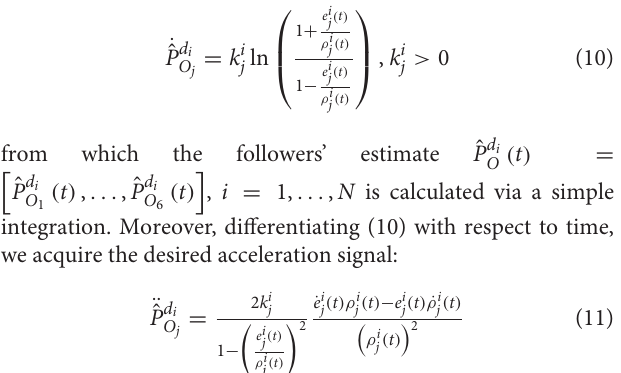
1, . . . , N via their own state measurements by adopting